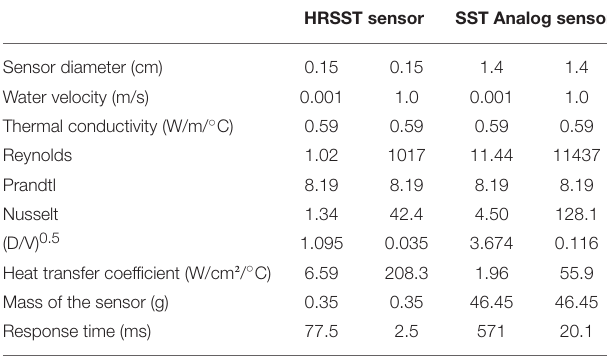
TABLE 1 | Comparison of ratios D/V and response times for the HRSST sensor and the SST analog sensor in a seawater at 15 ◦ C and S =